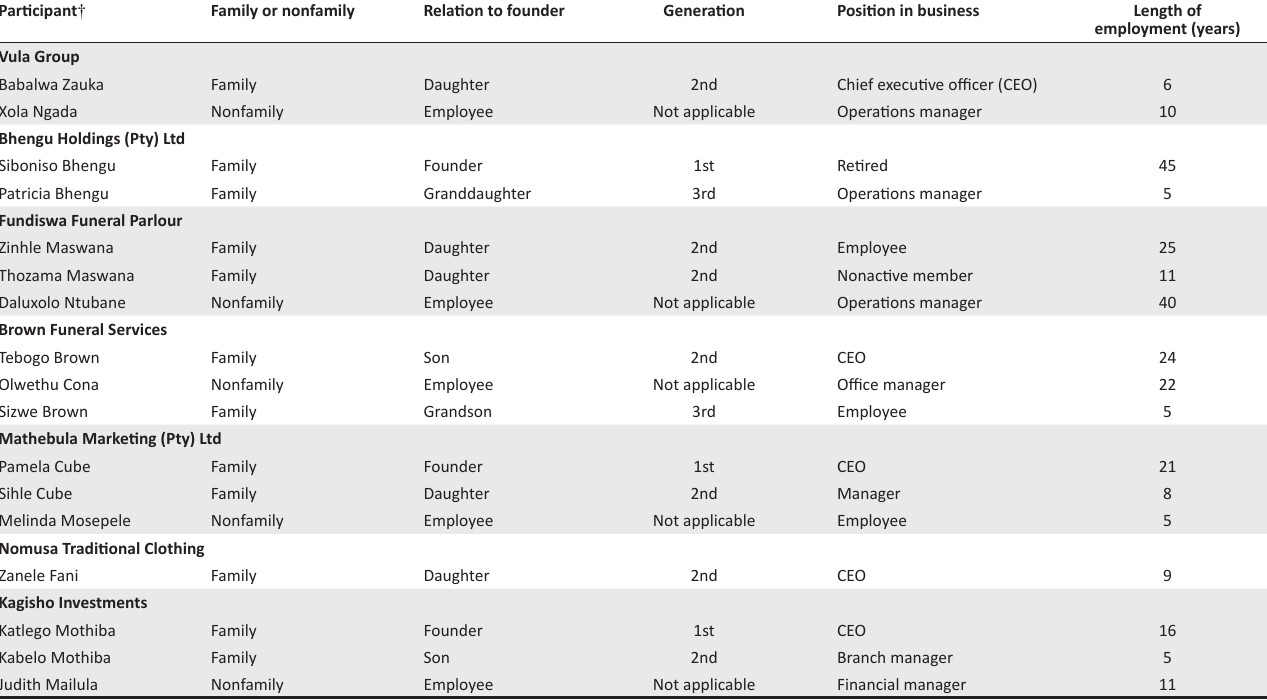
TABLE 1: List of family business cases and